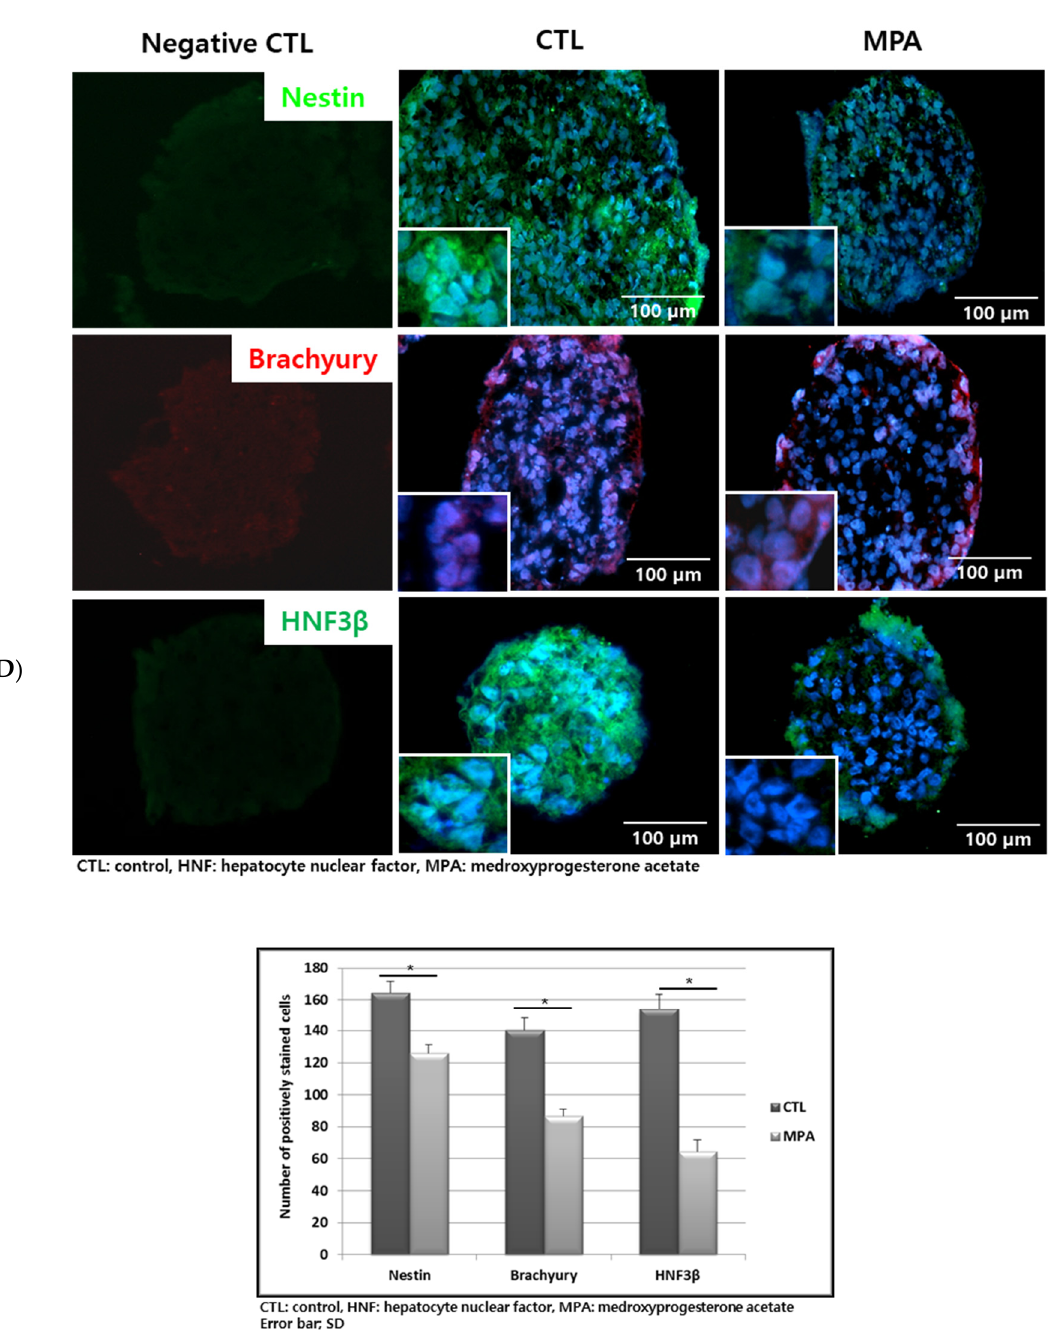
Figure 5. Effects natural progesterone and synthetic progestin on the expression of three germ layer genes in day 9 human embryoid bodies (hEBs). ( A ) The morphology did not differ according to the progesterone (P 4 ) treatment at 10 − 7 M for 5 days. The medroxyprogesterone acetate (MPA)-treated hEBs were unformed and became loose. The red bar of each picture indicates the diameter of formed EBs. ( B ) P 4 treatment at 10 − 7 M for 5 days did not alter the expression of germ layer genes. ( C ) MPA treatment at 10 − 7 M for 5 days induced down-regulated expression of all tested genes (* p < 0.05, respectively, CTL: untreated hEBs), upper panel. RU486 treatment negated the e ff ects of MPA (CTL: MPA-treated hEBs), lower panel. ( D ) Immunostaining of three germ layer genes on the hEBs treated with MPA. Counts of positively stained cells were evaluated and compared between the groups (* p < 0.05).